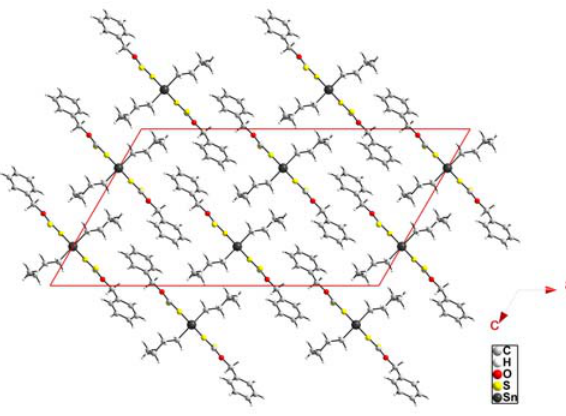
Figure 5. The packing arrangement of the complex [ ( n -Bu) ] ( 8 ) viewed along the b-axis. Sn(S COCH C H ) 2 2 6 5 2